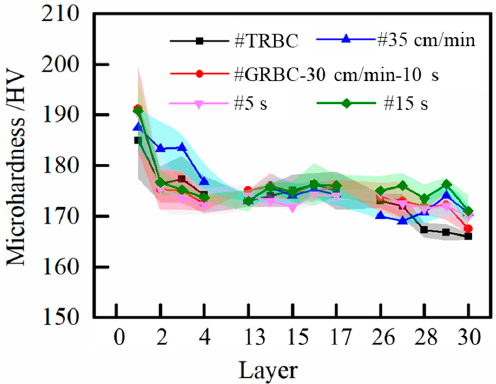
Figure 9. Microhardness curves measured on transverse sections of different layers of different samples. (TRBC and GRBC represent transient and gradual reduction of bottom current, respectively).